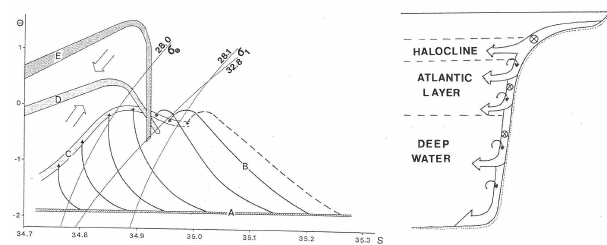
Fig. 16. Schematics showing to the left the evolution of the char- acteristics of dense shelf waters (A) due to entrainment as they sink down the continental slope (B) . Depending upon the initial salinity the final characteristics form an envelope (C) , which merges with the boundary current (E) to form the transformed water column (D) . An idealised picture of plumes sinking to different depth is shown to the right. From Rudels and Quadfasel (1991).